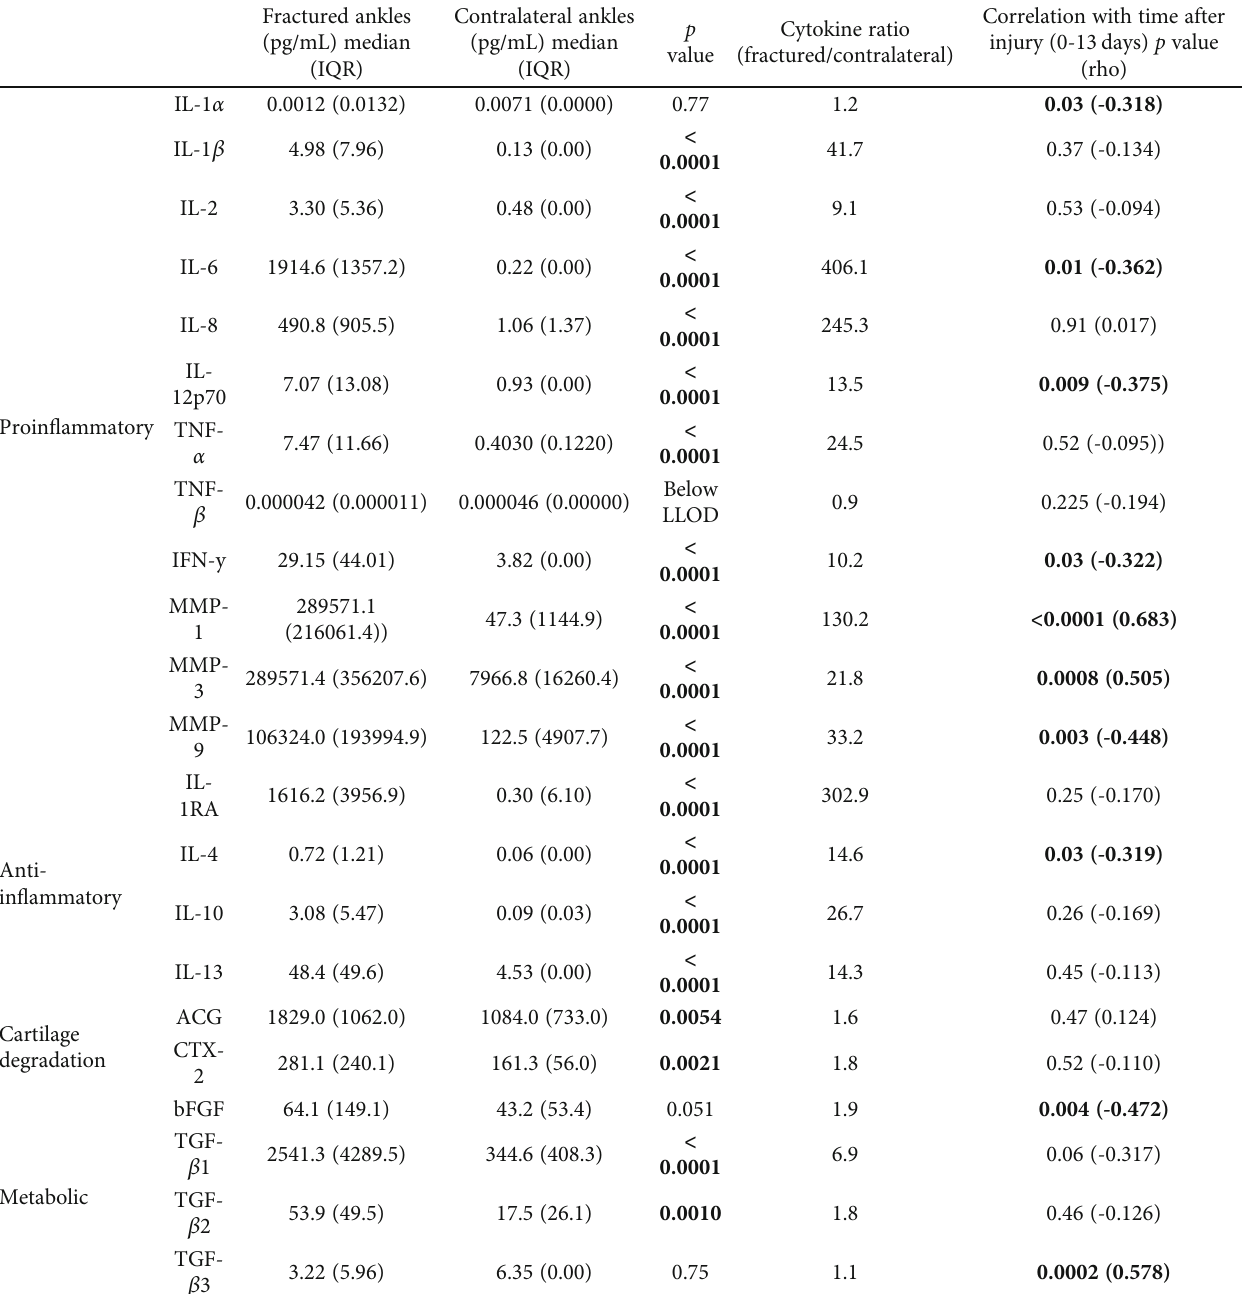
Table 1: Cytokine level in fractured ankles compared to healthy contralateral